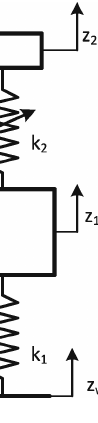
Figure 3. Calculation diagram of the vibration reduction system